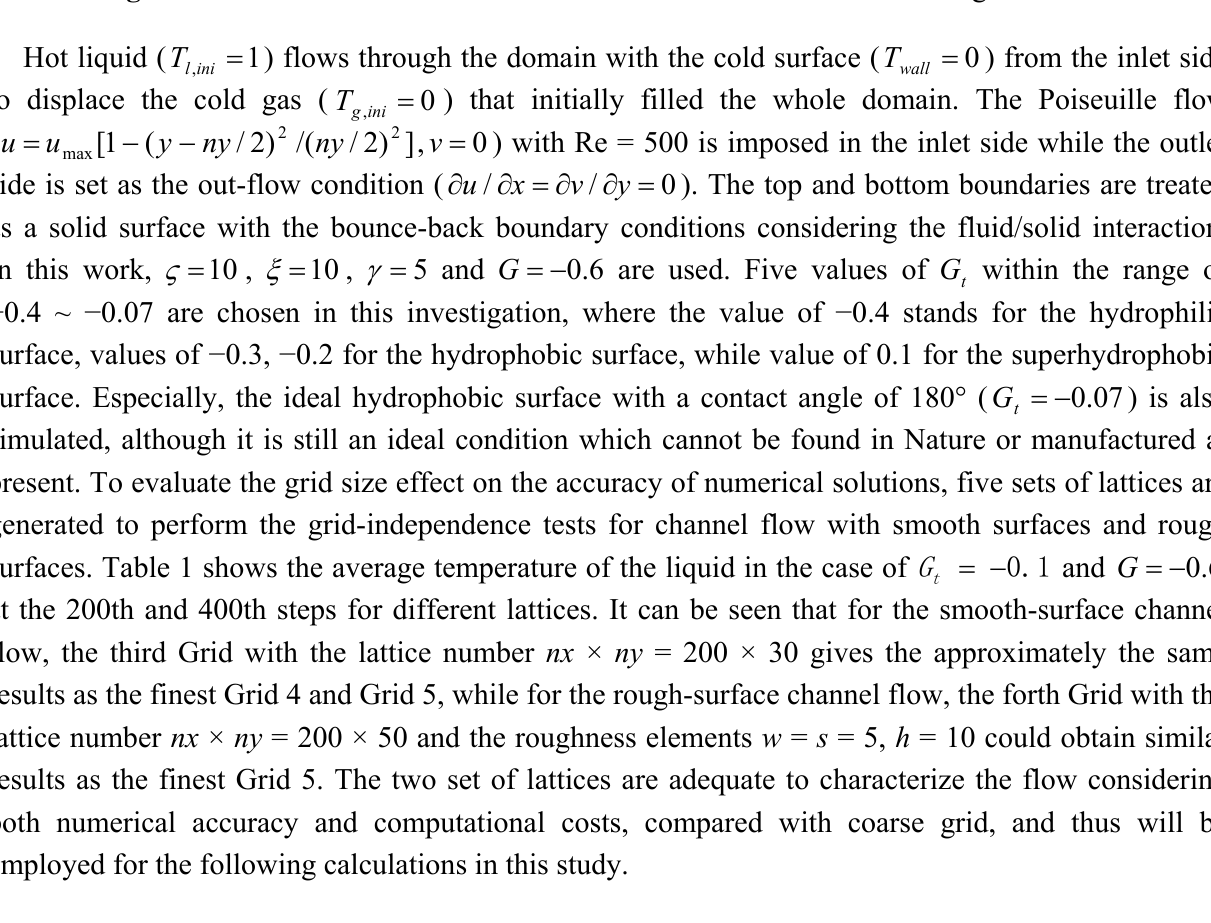
Figure 5. The structure scheme of channel with smooth surfaces and rough